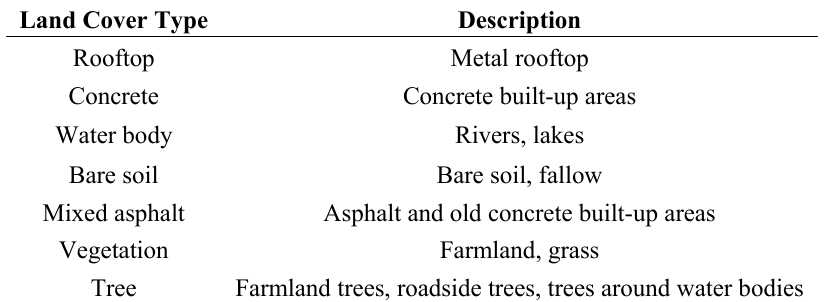
Table 4. Land Cover Types (LCTs) for classification using WordView-2 image and SASI